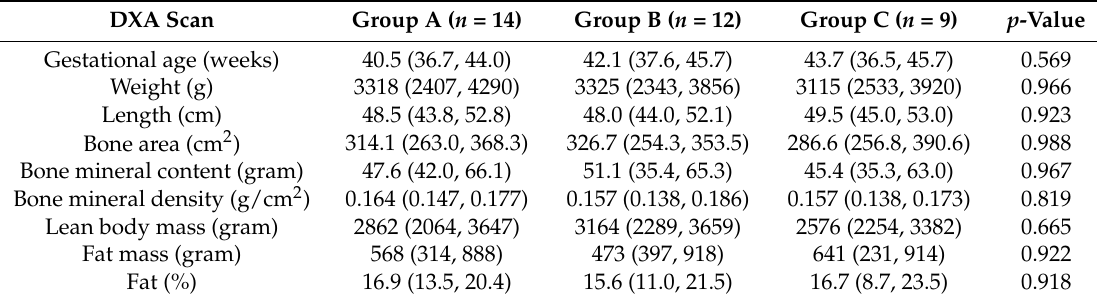
Table 4. Body composition measured by